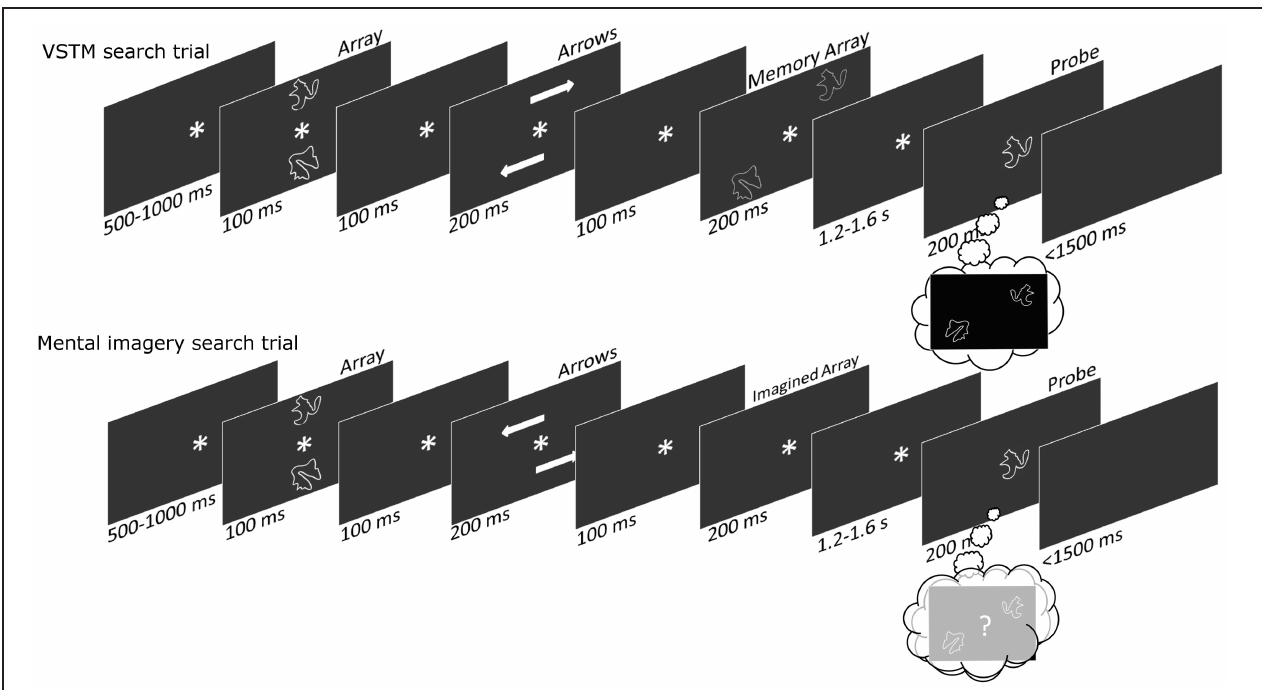
judgment). On the Imagery-search trials subjects are presented with midline but not laterally located shapes, before being presented with a central probe shape (upon which they make an imagined location